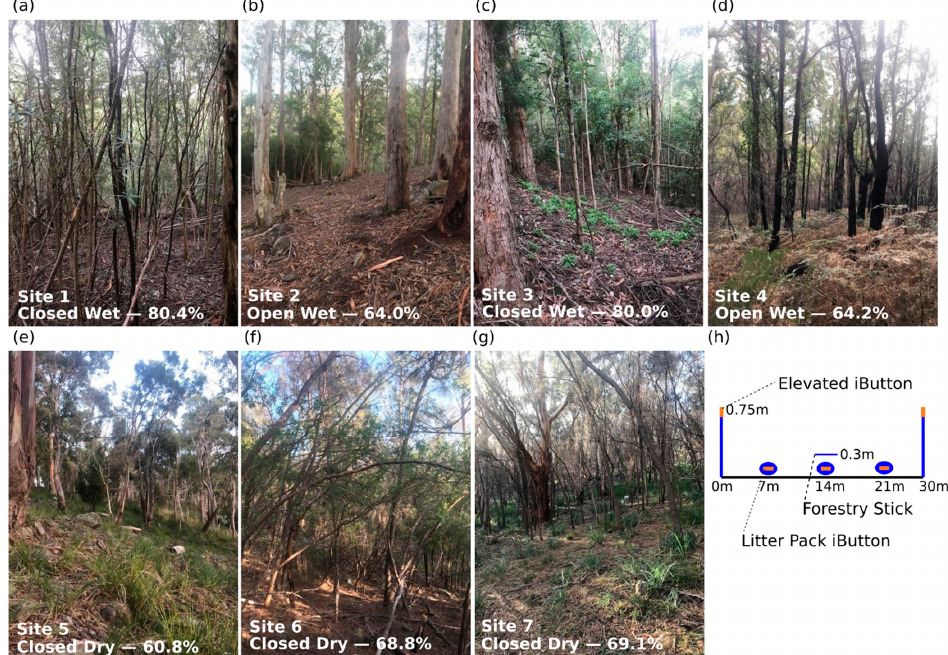
Figure 2. Photographs of the seven study sites (four wet and three dry Eucalyptus forests) near Hobart, Tasmania. Site number and site code, vegetation type, and fuel treatment are as follows: ( a ) Site 1 (PDC2)—wet forest that has remained unburned since 1967; ( b ) Site 2 (PDFB2)—wet forest subject to mechanical thinning removal of elevated fuels; ( c ) Site 3 (SAC4)—wet forest that has remained unburned since 1967 ( d ). Site 4 (SAPB4)—wet forest burned by a prescribed fire in March 2021; ( e ) Site 5 (LGMT3.NT)—dry forest unburned since 1997, subject to mechanical thinning; ( f ) Site 6 (LG PB1)—dry forest burned in 1997 and then by a prescribed fire in April 2021; ( g ) Site 7 (LGMT3.C)—dry forest unburned since 1997. Estimates of canopy cover percentage using a densi- tometer are indicated for each site is indicated. All the dry forest sites have northly aspects, whereas wet forest sites 1 and 2 had southerly aspects and sites 3 and 4 northerly aspects, albeit on the edge of a riparian zone. The forest types differ with respect to elevation and rainfall (wet 300–450 m vs. dry 250–300 m and wet 1000 mm vs. dry 600 mm per annum). ( h ) The layout on the transects of the suspended Hygrochron iButton, fuel moisture disks, and fuel moisture sticks is also shown.